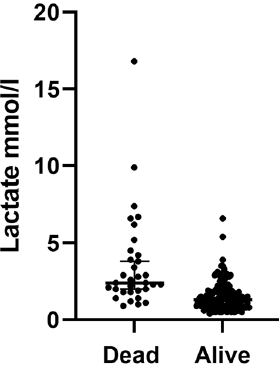
Figure 2. Lactate levels at admission among the patients that died and survived. Data as individual plots, lines = median and 25th–75th centiles.